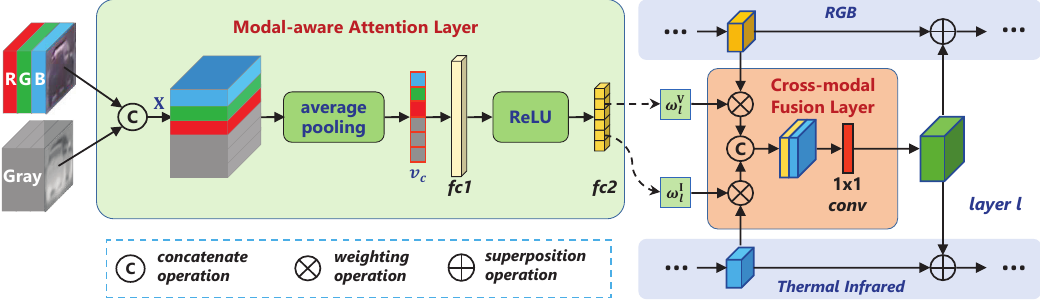
Figure 2. Schematic diagram of modal-aware attention